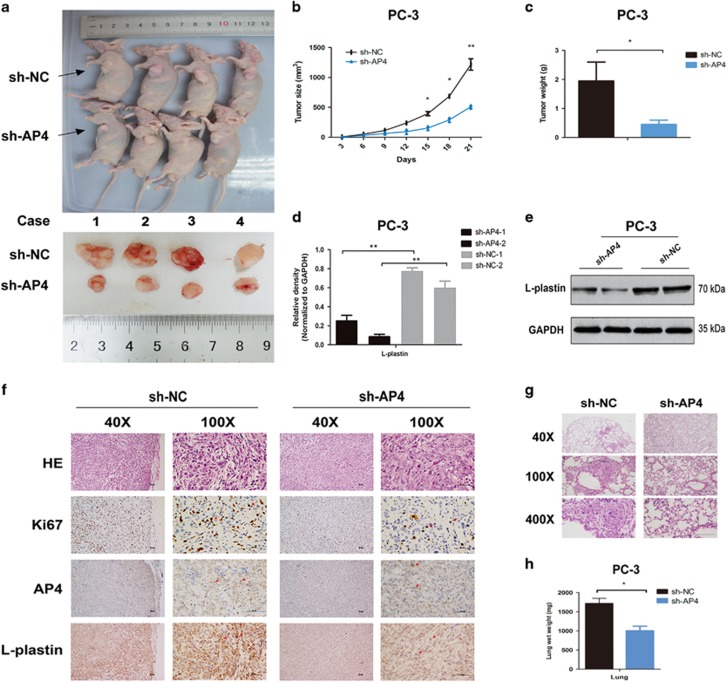
AP4 promotes tumorigenicity and metastatic potential in vivo. (a–c) The images of animals and tumors were shown. Tumor weights were shown as the means±S.D. when the tumors were collected. (d,e) qRT-PCR and western blot analyzed the expression of L-plastin in tumor tissues from sh-AP4 in PC-3 cells compared with sh-NC cells. (f) Representative images of HE and IHC staining of the tumor. The IHC staining showed that AP4 knockdown decreased the proliferation index Ki67. (g,h) Representative images of lung metastasis of subcutaneous xenografts assay. Histological analysis of lung wet weight is presented as the mean±S.D. (n=4). *P<0.05, **P<0.01